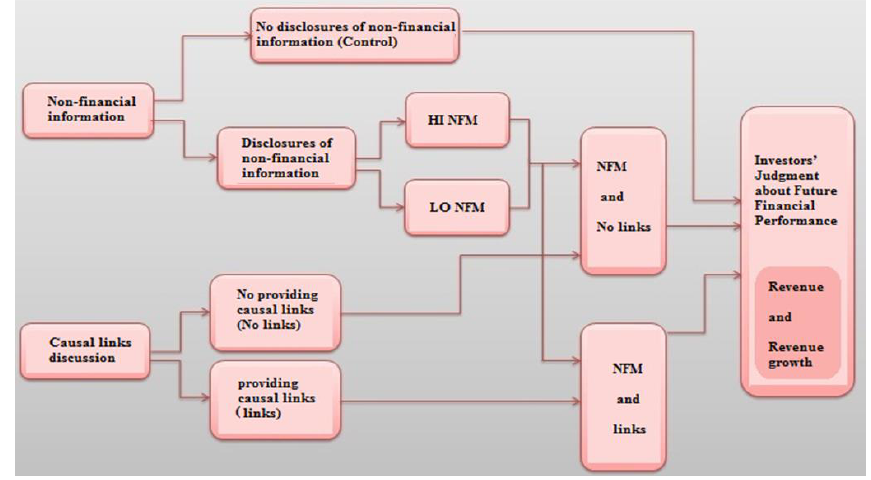
Figure 1. Conceptual Model